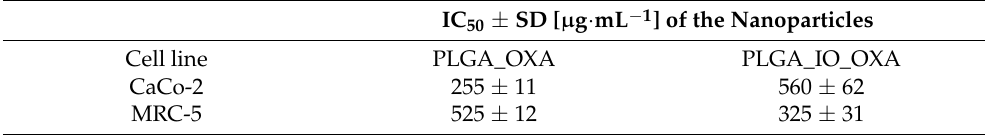
Table 2. Evaluation of in vitro metabolic activity of human cells derived from colorectal carcinoma (CaCo-2) and human primary fibroblasts (MRC-5) treated with PLGA_OXA and PLGA_IO_OXA for 72 h determined by WST-1 assay. IC 50 —concentration of the nanoparticles required to achieve 50 % reduction in cell viability; SD—standard deviation (from four replicates).